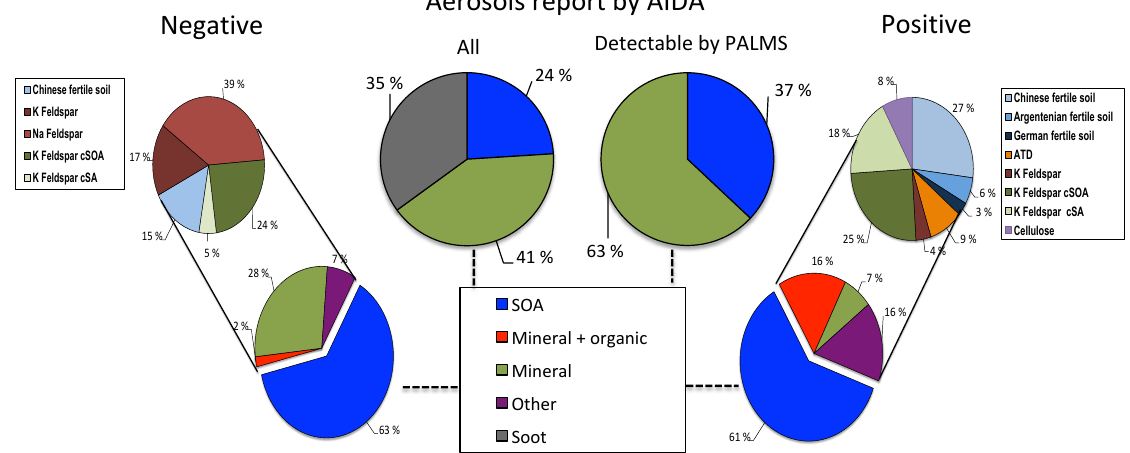
Figure 5. Model predictions of ∼ 5000 aerosols sampled from the AIDA FIN01 blind mixture, which was known to be a subset of the training data. All percentages represent relative number concentrations. Middle left: aerosol types input to the chamber for the blind mixture. Middle right: aerosol types input to the chamber for the blind mixture and above the detection limit for PALMS. Model predictions are shown for negative and positive ion mode on the left and right, respectively. Bottom: broad categories. Top: breakout by aerosol type of the non-SOA categories above the 1% level. Note that (1) the soot in the blind mixture was known to be below the instrument detection limit and therefore is not expected to be found in the data (Cziczo et al., 2006); (2) coagulation of SOA and mineral dust, which occurred after aerosol input to the chamber, was often categorized as mixed mineral and organic particles or fertile soils (i.e., mixtures of mineral and organic components) considered in the training data set; and (3) the aerosols types reported by AIDA do not account for PALMS transmission efficiency (see text for